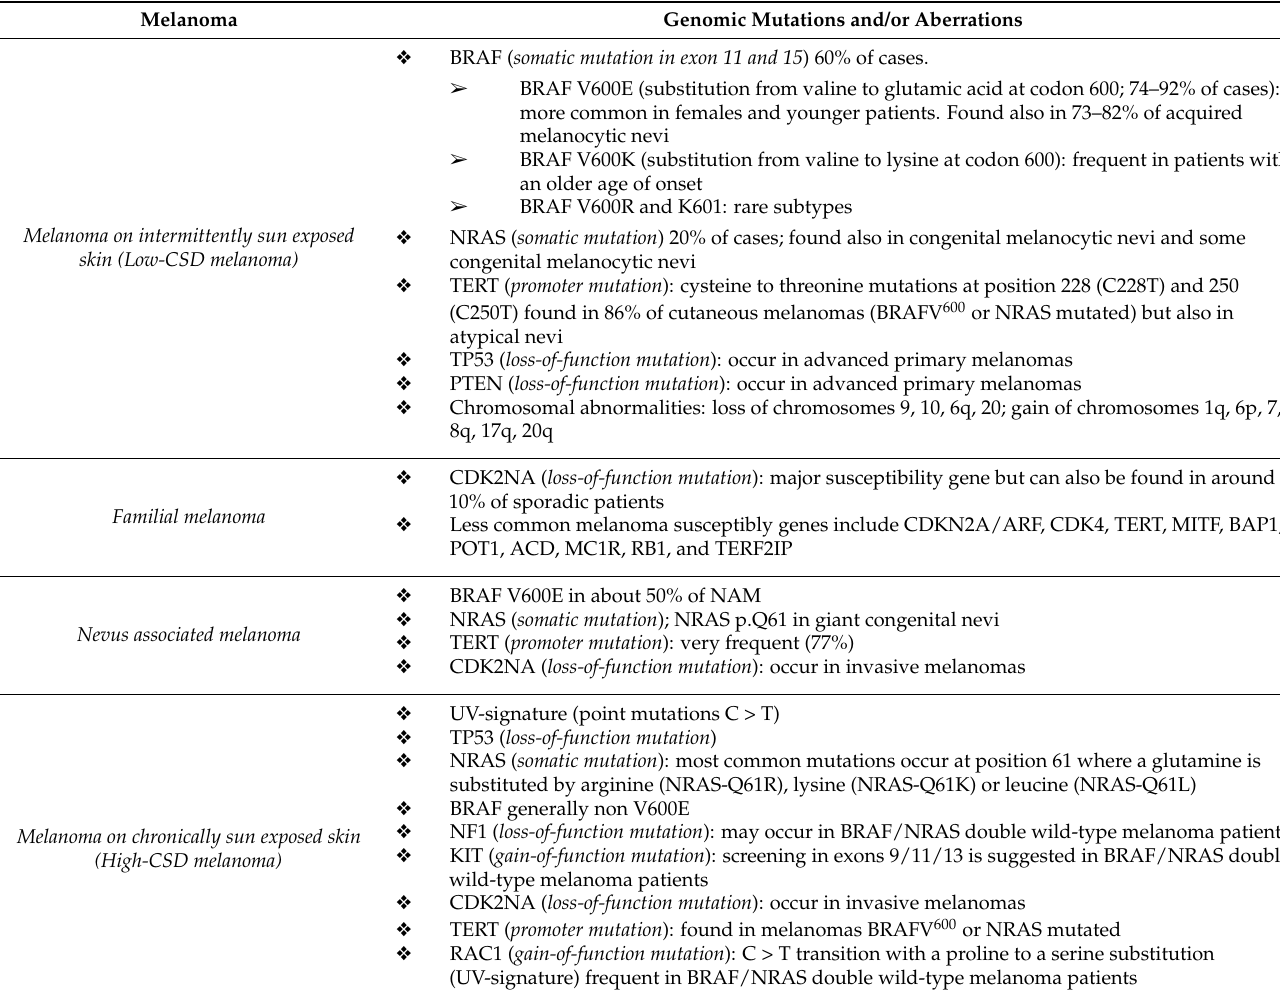
Table 1. Melanomas and genomic mutations and/or aberrations. Melanoma Genomic Mutations and/or Aberrations